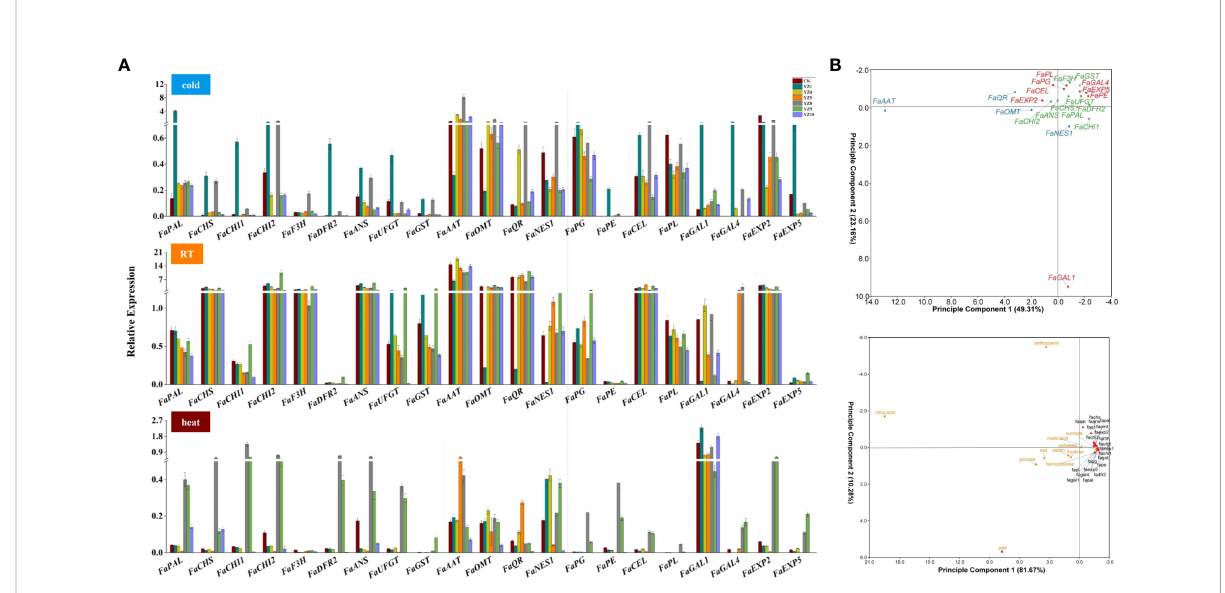
FIGURE 8 The expression level of key genes related to aroma, cell wall, and anthocyanin synthesis in the fruits of YZs-overexpressing strawberry and PCA analysis. (A) The expression levels of genes related to anthocyanin synthesis (phenylalanine ammonia-lyase (FaPAL), chalcone synthase (FaCHS), chalcone isomerase (FaCHI1, FaCHI2), fl avanone 3-hydroxylase (FaF3H), dihydro fl avonol 4-reductase (FaDFR1, FaDFR2), anthocyanidin synthase (FaANS), UDP glucose: fl avonoid 3-o-glycosyl transferase (FaUFGT), glutathione s-transferase (FaGST)), aroma formation (alcohol acyltransferases (FaAAT), o-methyltransferase (FaOMT), quinone oxidoreductase (FaQR), nerolidol synthase (FaNES1)), and cell wall metabolism (polygalacturonase (FaPG), pectinmethylesterase (FaPE), endo- b -1,4-glucanases (FaCEL), pectate lyase (FaPL), b -D-galaetosidase (FaGAL1, FaGAL4), expansin (FaEXP2, FaEXP5)) under different storage temperatures; (B) PCA analysis of the expression level of 21 related genes, as well as other quality traits, including malic acid, citric acid, glucose, fructose, sucrose, POD, SOD, hemicellulose, pectin, cellulose,